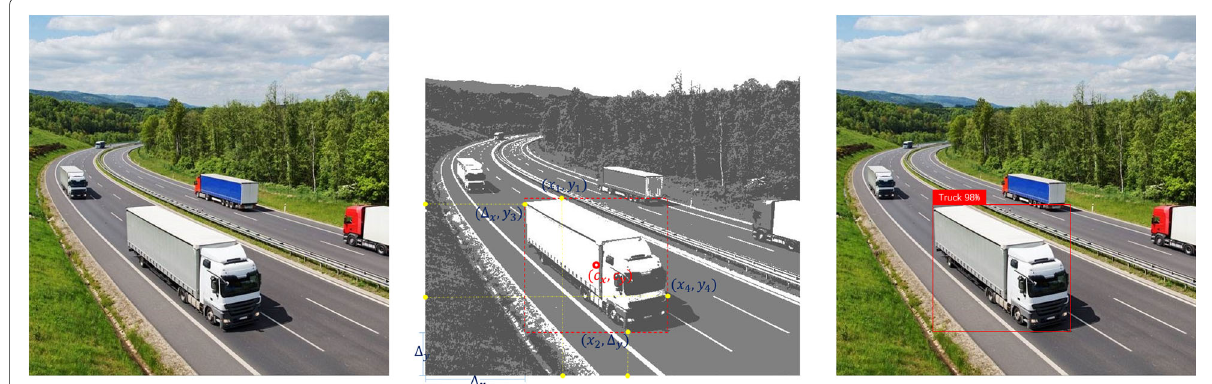
Fig. 4 Hardware frame diagram of security monitoring